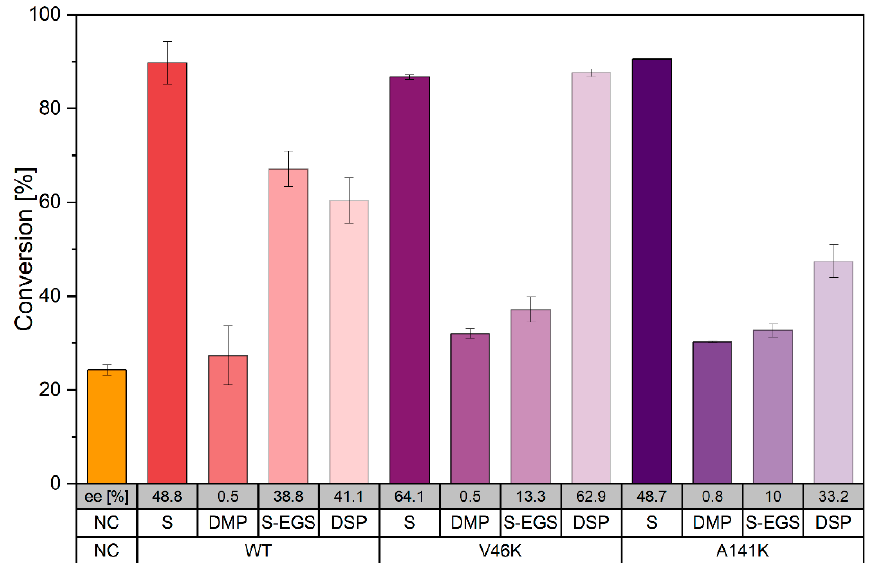
Figure 4. Conversion and product enantiomeric excess obtained in reactions of 20 mM cyclohexene oxide with 40 mM azide using 100 µg biocatalyst (soluble or CLECs) after 24 h. A 20 mM cross-linker concentration was used during cross-linking with DMP and Sulfo-EGS. In case of DSP, 4 mM, 10 mM or 20 mM cross-linker concentration was applied for cross-linking of HheG variants V46K, A141K and wild type, respectively. Measurements were performed in quintuplicates. ‘NC’ indicates negative control and ‘S’ soluble enzyme. The product enantiomeric excess (ee) obtained in the negative control reaction was 0.5%.